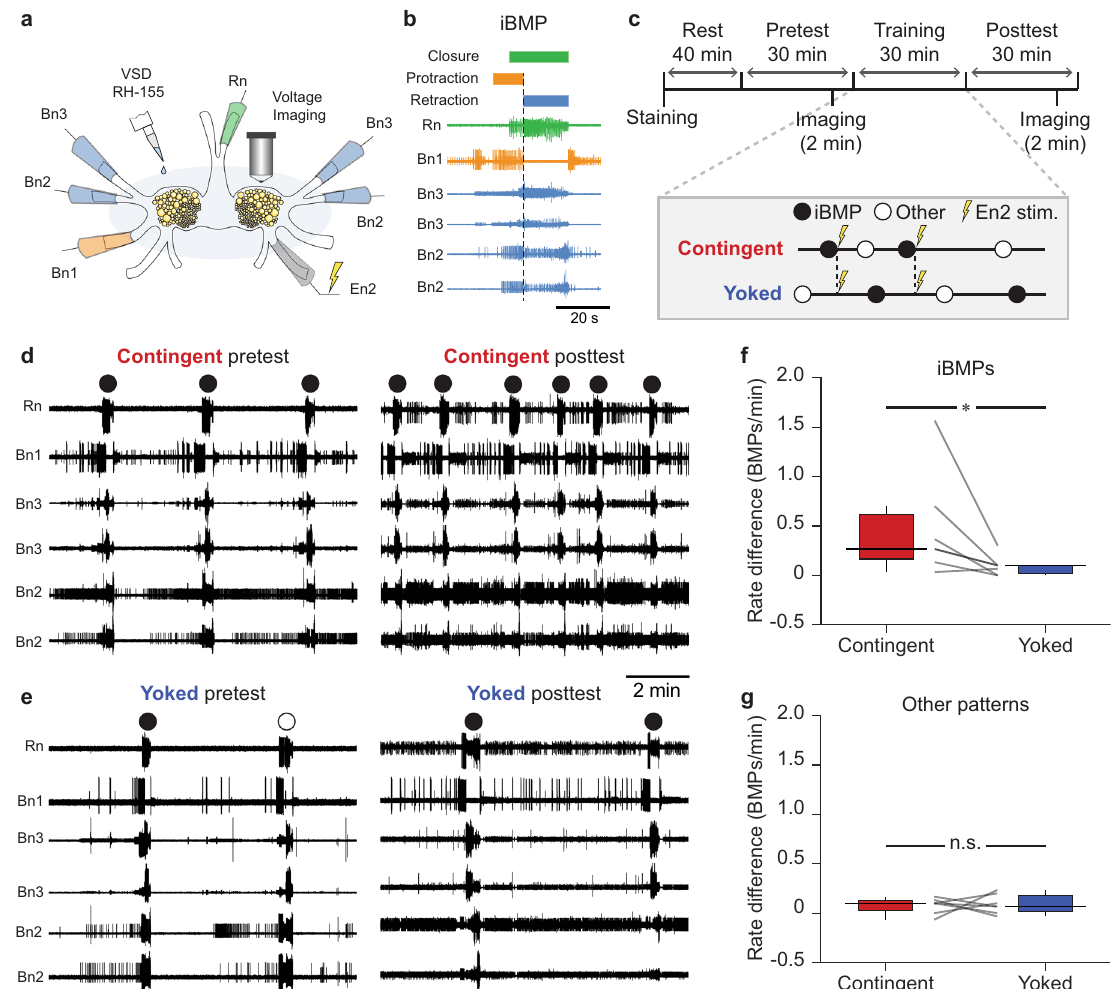
Fig. 1 In vitro analog of operant conditioning. a Schematic of isolated ganglia for simultaneous extracellular electrophysiology and VSD imaging. b Example BMP. c Timeline and training paradigm. d , e Examples of nerve activity before and after contingent ( d ) or yoked training ( e ). f Contingently trained preparations had a greater increase in the rate of iBMPs compared to yoked preparations (Wilcoxon signed-rank test, P = 0.03, W = − 26, N = 7; medians: contingent = 0.27, yoked = 0.10 BMPs/min). g No signi fi cant difference was observed for other patterns ( P = 0.94, W = − 2, N = 7; medians: contingent = 0.10, yoked = 0.07 BMPs/min). BMP rates were pretest-subtracted. Individual datums represent preparations. Box plots show median (line), quartiles (box), and range